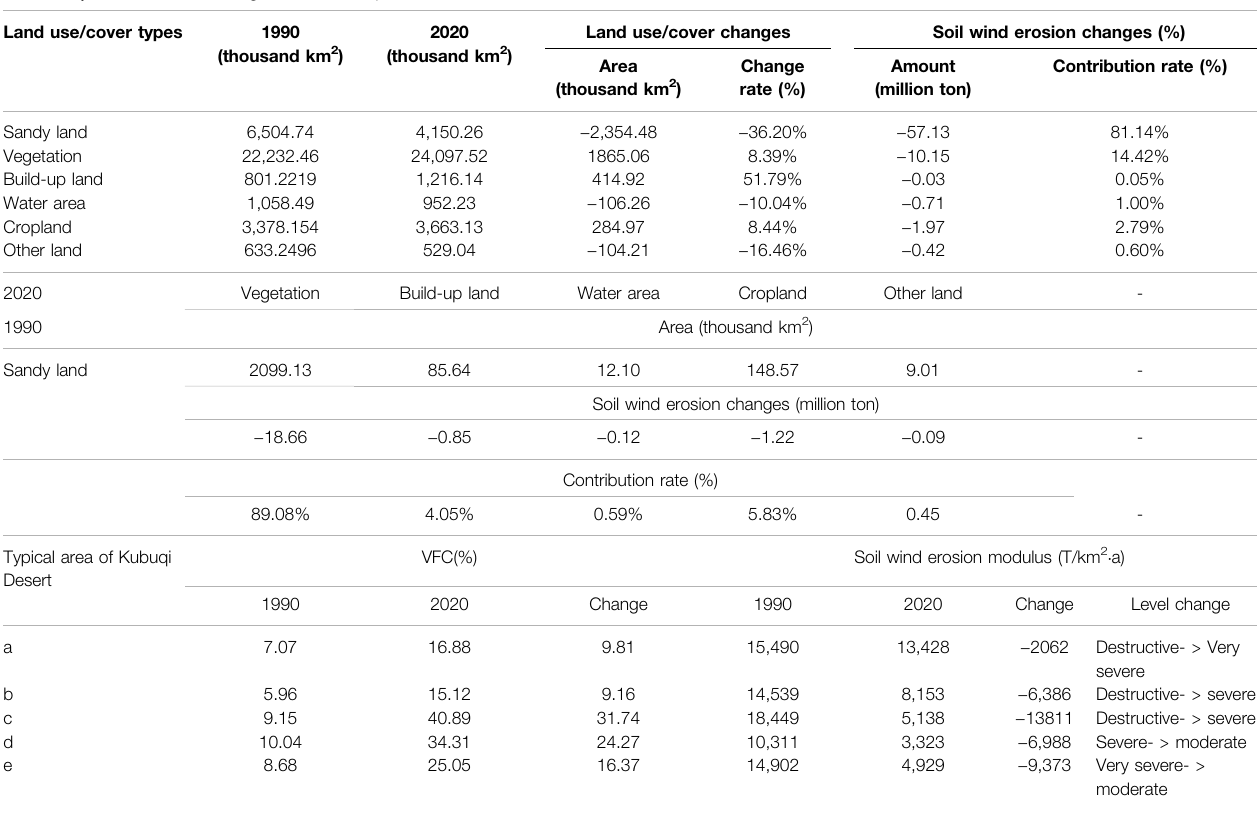
TABLE 4 | Land use/cover changes in the Kubuqi Desert from 1990 to